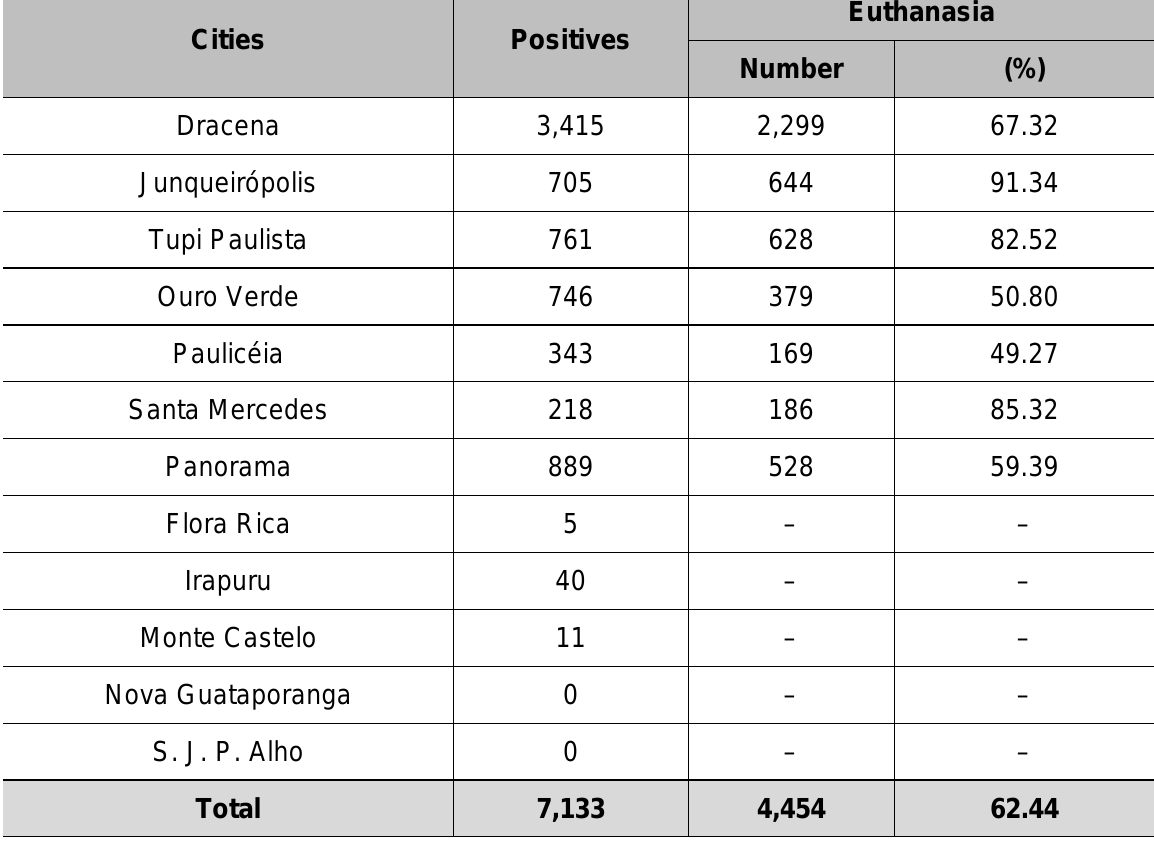
Table 5. Porcentage of euthanasia in AVL seroreactive dogs in the cities of Dracena microregion, Alta Paulista (SP), from August 2005 to January